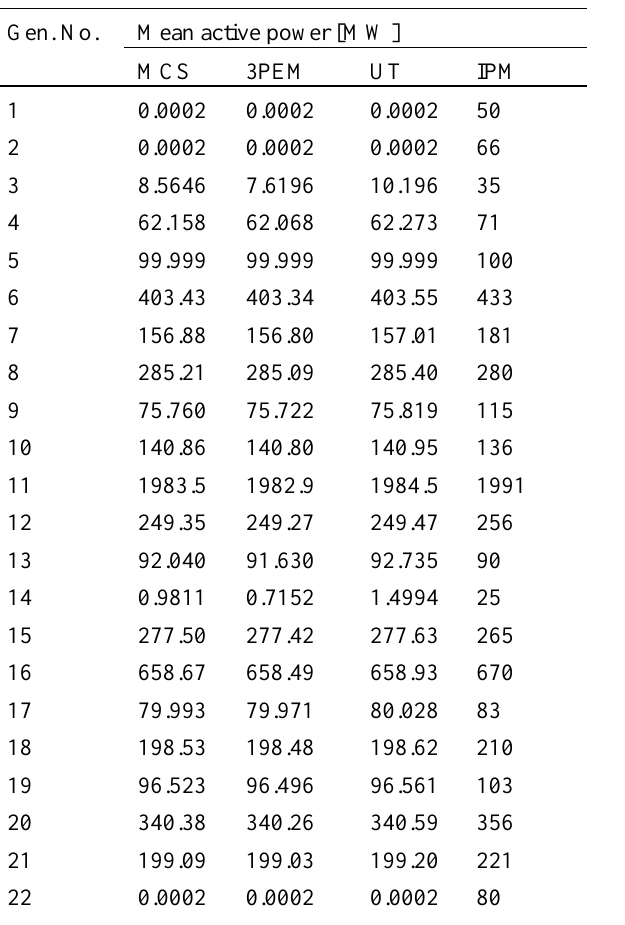
Comparison of the results in term of the average change in generated powers [MW] Gen.